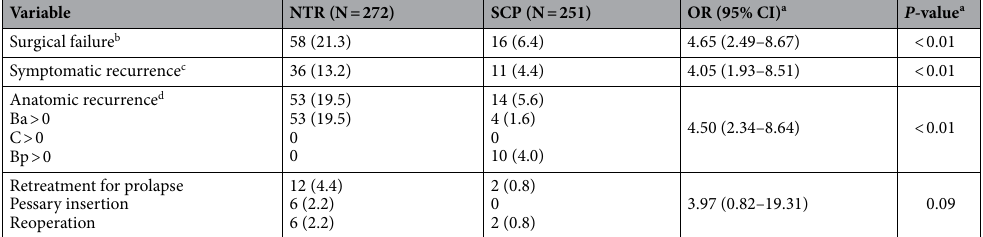
Table 3. Prolapse treatment outcomes. Data are presented as number (%). CI, confidence interval; NTR, native tissue repair; OR, odds ratio; SCP, sacrocolpopexy. a Adjusted for age and preoperative POPQ stage. b Symptomatic or anatomic recurrence or retreatment for prolapse. c Presence of vaginal bulge symptoms defined as an affirmative response to question 3 on the PFDI-20. d Presence of any POPQ point beyond the